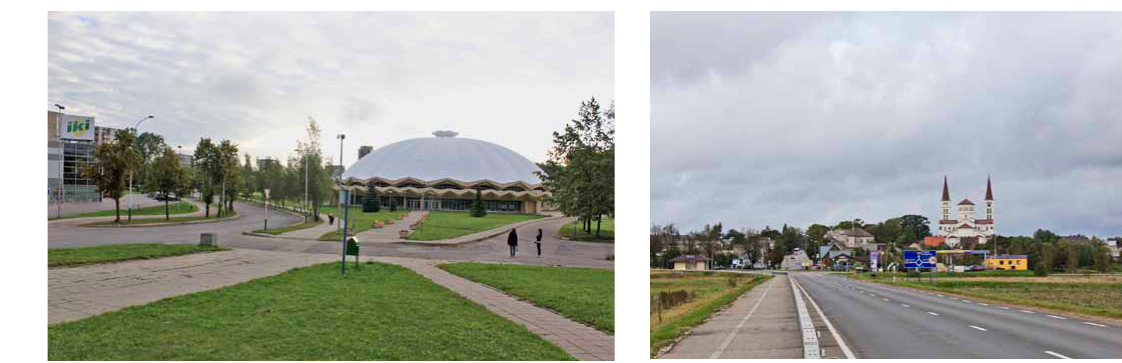
fig. 18. Elektrėnai is a new town whose identity is marked by its adjustment to natural conditions, i.e. hilly terrain line and water ponds, thus creating attractive urban interior spaces.